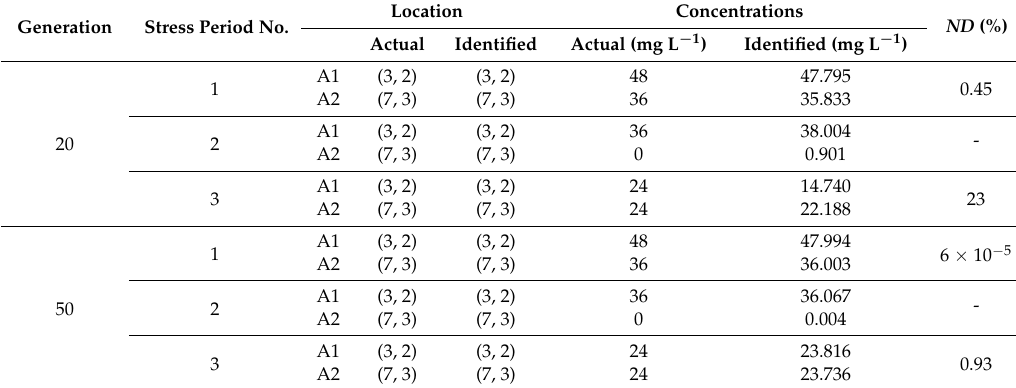
Table 10. Comparison of actual and identified characteristics when the generation number is 20 and 50. Generation Stress Period No.